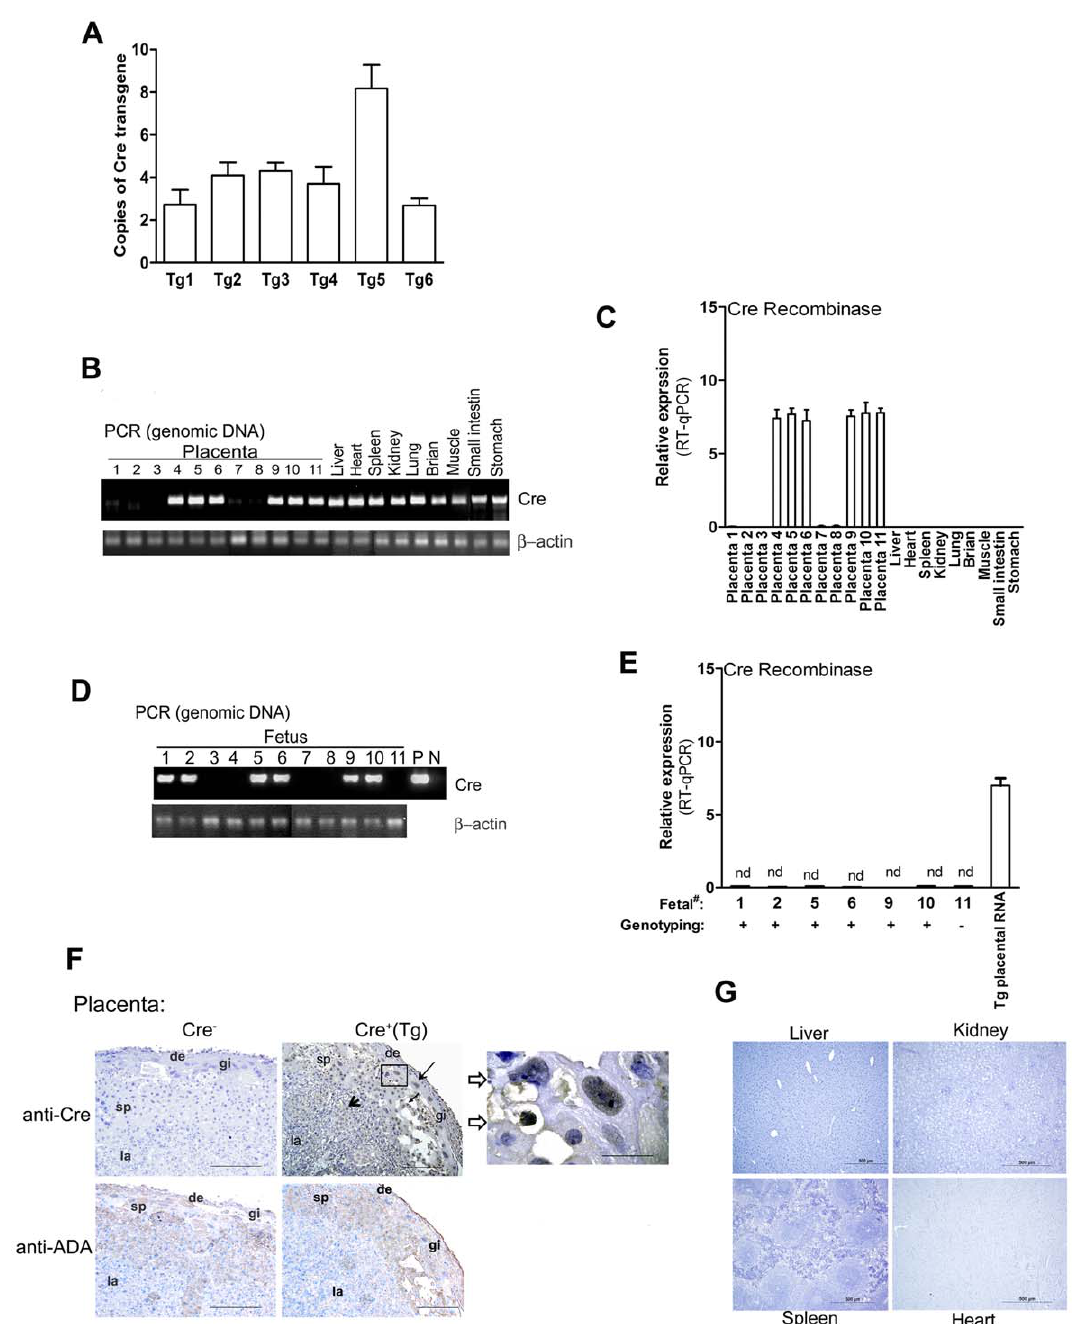
Figure 3. Placenta-restricted gene expression in Tpbpa r/ Ada f- Ada P- Cre transgenic mice. Pregnant mice were sacrificed on gestation day 16.5 and placentas, multiple organs and embryos were collected. ( A ) Copy number of transgenes was determined by qPCR analysis in Tpbpa r/ Ada f- Ada P- Cre transgenic founders. Genotyping analysis ( B , D ) of Tpbpa r/ Ada f- Ada P- Cre transgenes by PCR and expression pattern of Cre mRNA ( C , E ) analyzed by RT-qPCR in placenta, fetus and multiple maternal organs from female transgenic mice (derived from Tg 5 founder) mated with wild type FVB male mice. b -actin was used as an internal control. Tg placental RNA is used as positive control. nd, not detectable; P, Positive control; N, Negative control. ( F ) Immunochemistry staining of Cre recombinase using anti-Cre antibody in the placentas of pregnant Tpbpa r /Ada f -Ada P -Cre females mated with wild type FVB males. Placentas with Tpbpa r /Ada f- Ada P- Cre transgenes (Cr + (Tg)) expressed Cre protein in giant cells (indicated by long arrow), spongiotrophoblast cells (indicated by short arrow) and cells in the labyrinthine zone (indiated by arrow head)of placentas, with highest expression in the spongiotrophoblast zone. Panel F (inset) showed nuclear localization of Cre in trophoblast cells. Placentas lacking Tpbpa r/ Ada f- Ada P-Cre transgenes (Cre 2 , panel F ) and multiple organs from pregnant transgenic dams ( G ) showed no Cre immunostaining. Endogenous ADA immunostaining was performed in placentas with or without Tpbpa r/ Ada f- Ada P-Cre transgenes using anti-ADA antibody (panel F ). Scale bar, 100 m m (placenta) or 50 m m (inset) and 500 m m for maternal organs.